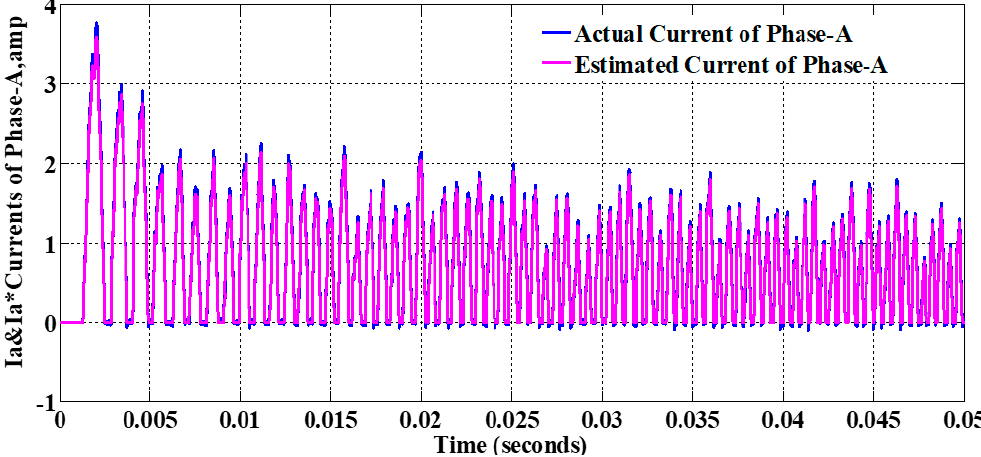
Figure 9. Estimated and actual phase-A currents.